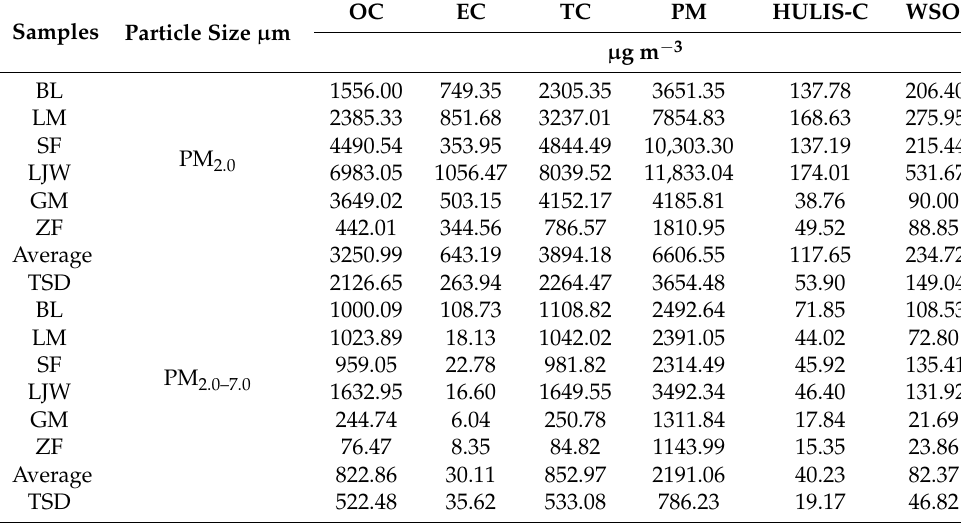
Table 5. Concentrations of OCx, WSOCx, and HULIS-C in PM 2.0 and PM 2.0~7.0 from RCC